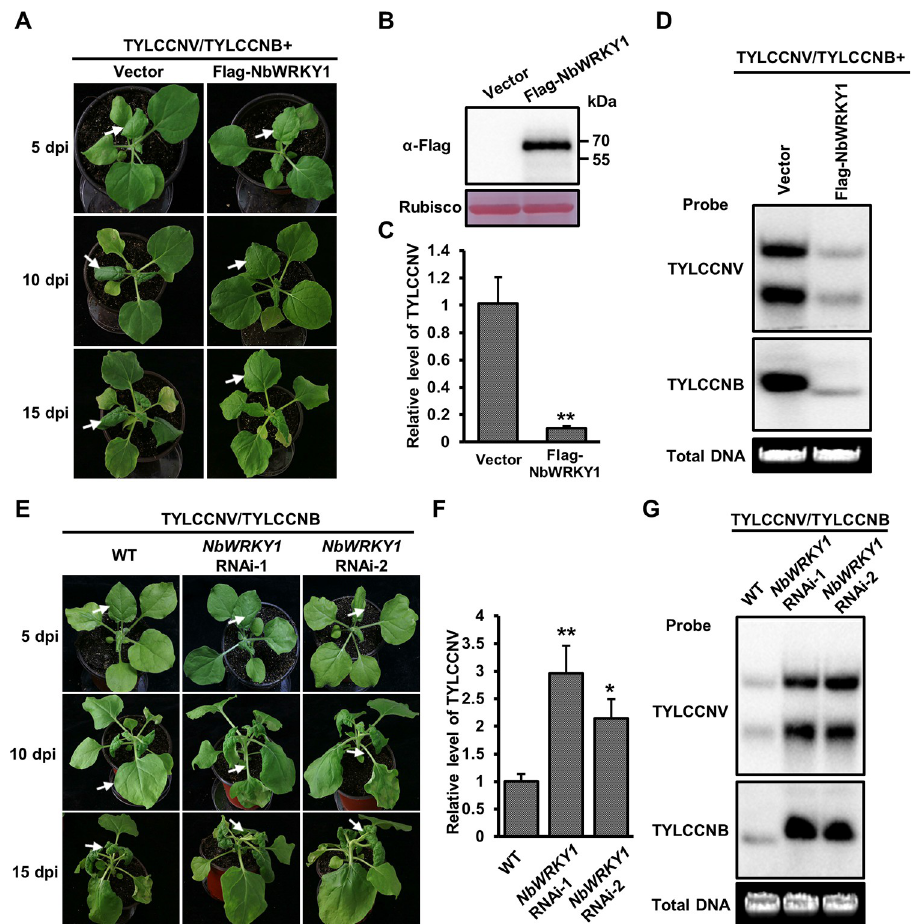
Fig 2. NbWRKY1 positively regulates plant defense against TYLCCNV/TYLCCNB. (A) Effect of the transient overexpression of NbWRKY1 on the symptoms induced by TYLCCNV/TYLCCNB. N . benthamiana plants were inoculated with TYLCCNV/TYLCCNB and Flag-NbWRKY1 or TYLCCNV/TYLCCNB and pCambia-Flag (the vector control) and symptoms were monitored and recorded at 5, 10 and 15 dpi, respectively. (B) Western blot analysis of the expression of Flag-NbWRKY1 in the infiltrated leaf samples at 48 hours post infiltration (hpi). (C) Quantitative PCR (qPCR) analysis of the relative accumulation of TYLCCNV DNA in the plants shown in (A) at 10 dpi. (D) Southern blot analysis of viral DNA accumulation in the systemic leaves of the inoculated plants as shown in (A) at 10 dpi. (E) Symptoms of the TYLCCNV/TYLCCNB-inoculated wild-type (WT) and NbWRKY1 RNAi N . benthamiana plants at 5, 10, and 15 dpi, respectively. (F) qPCR analysis of the relative accumulation of TYLCCNV DNA in the plants shown in (E) at 10 dpi. (G) Southern blot analysis of viral DNA accumulation in the systemic leaves of the inoculated plants as shown in (E) at 10 dpi. White arrows indicate different severity of the corresponding leaves. 25S rRNA was used as an internal control of qPCR. Mean and standard deviation of four independent plants are shown. Double and single asterisks indicate significant statistical differences between two treatments at p < 0.01 and p < 0.05 based on Student’s t test, respectively. The Gelstain-stained agarose gel serves as a loading